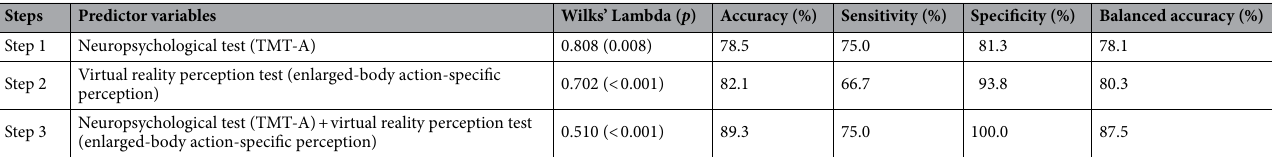
Table 4. Overall classification performance of the discriminant analysis model to diagnose